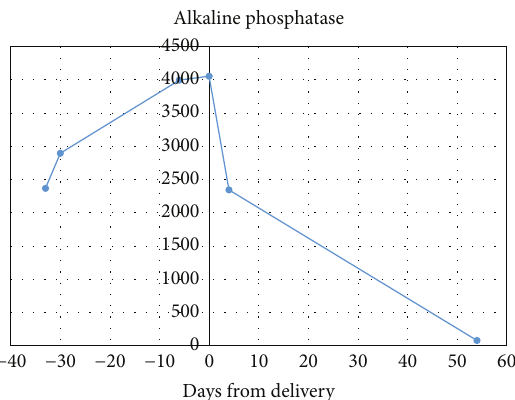
Figure 1: Alkaline phosphate levels trended over course of preg- nancy and postpartum